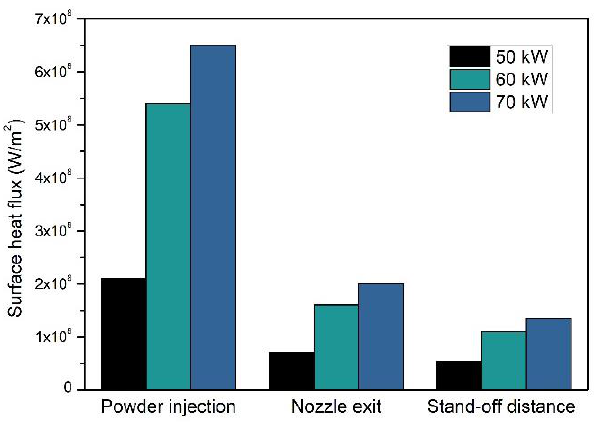
Figure 11. Surface heat flux from plasma gas to particles at different positions along the torch axis for different net torch powers. 60 SLPM of argon, 30 SLPM of helium, chamber pressure: 100 Pa.